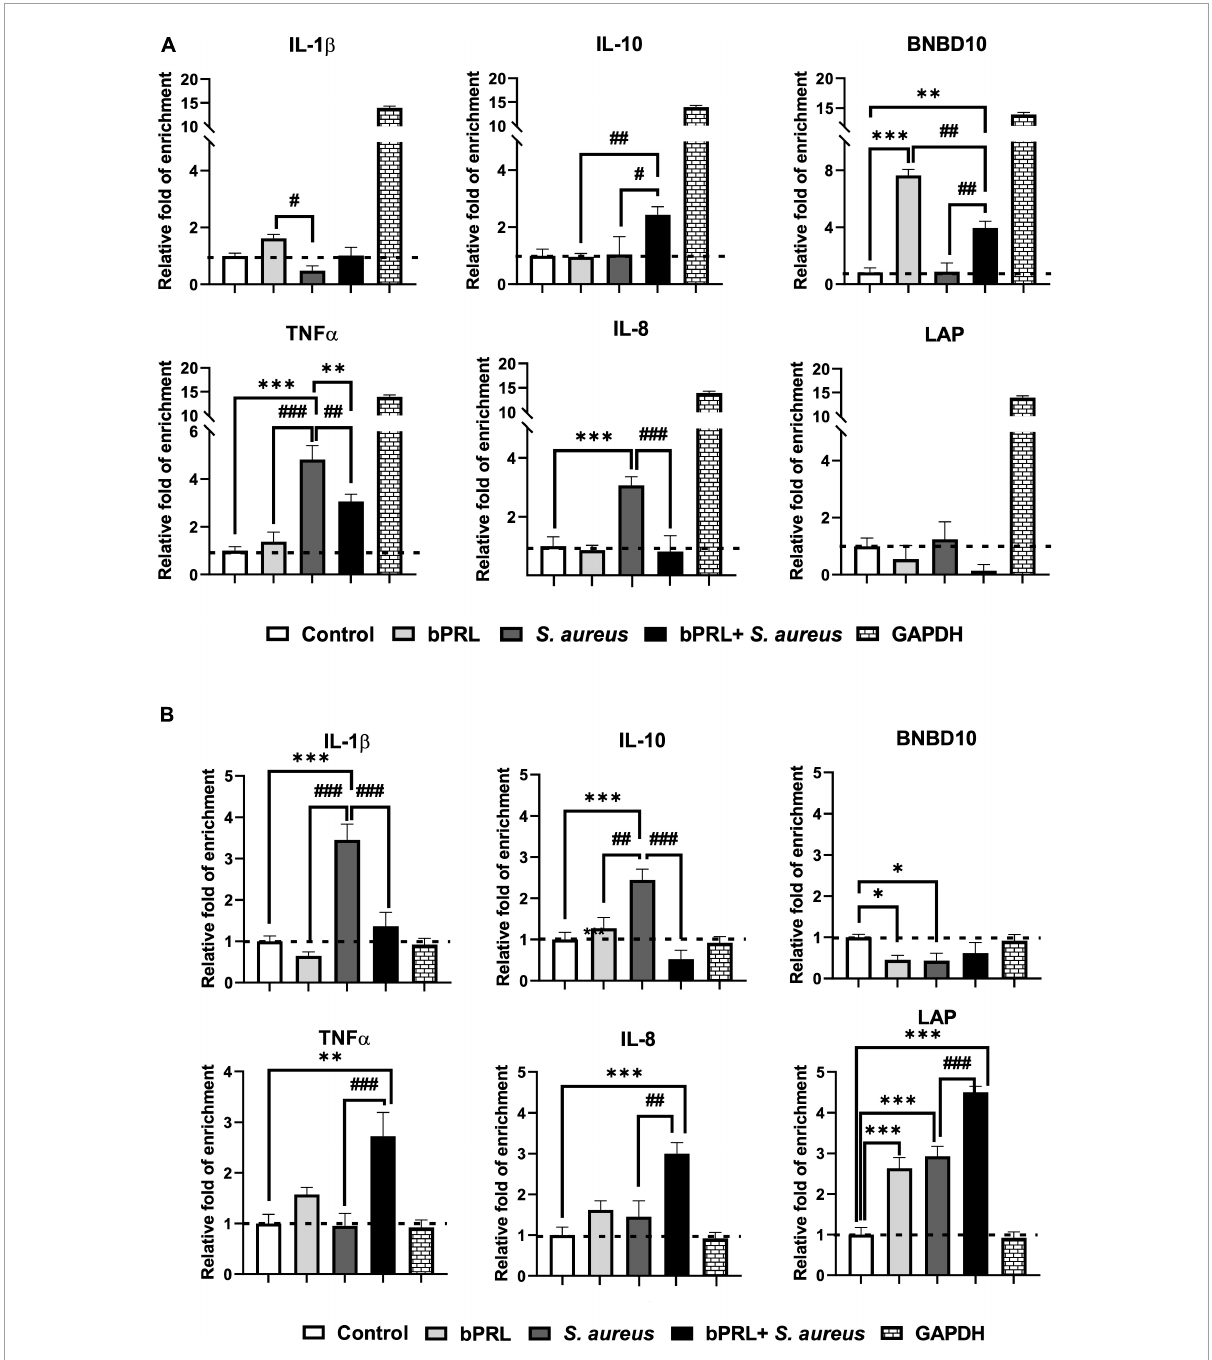
FIGURE3 Analysis of epigenetic modulation of H3K9ac and H3K9me2 marks in the promoter region of IIR elements in bMECs treated with bPRL and challenged with S. aureus . bMECs were treated 12 h with bPRL (5 ng/ml), and cells were or not challenged for 2 h with S. aureus (MOI = 30:1). (A) The ChIP-qPCR assay was performed to evaluate the relative enrichment of the H3K9ac mark on the promoter region of IL-1 β , IL-10 , BNBD10 , TNF- α , IL-8 , and LAP . (B) Relative enrichment of the H3K9me2 mark on the promoter region of IL-1 β , IL-10 , BNBD10 , TNF- α , IL-8 , and LAP . Control, bMECs without any treatment; bPRL, bMECs treated 12 h with bPRL (5 ng/ml); bPRL + S. aureus : bMECs treated 12 h with bPRL (5 ng/ml) and challenged with S. aureus (MOI = 30:1); S. aureus , bMECs only challenged with S. aureus (MOI = 30:1). The data were normalized regarding IgG-Ab isotype control, and the expression of control cells (cells without treatment) was considered as one. The data correspond to the mean ± SE from four independent experiments ( n = 4). “ ∗ ” ( p ≤ 0.05), “ ∗∗ ” ( p ≤ 0.01), and “ ∗∗∗ ” ( p ≤ 0.001) indicate a significant change regarding control (bMECs without any treatment). “#” ( p ≤ 0.05), “##” ( p ≤ 0.01), and “###” ( p ≤ 0.001) indicate a significant change regarding bMECs+ S. aureus condition. GAPDH was used as a positive control of enrichment (for H3K9ac) and not enrichment (for